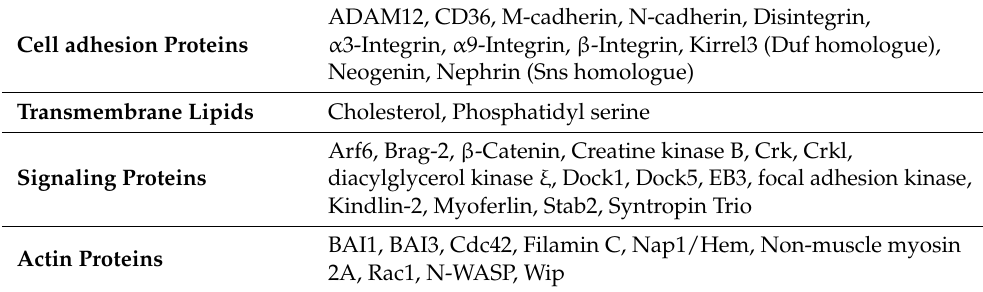
Table 2. Proteins that function in cell adhesion, signaling, and actin regulation in mammals.